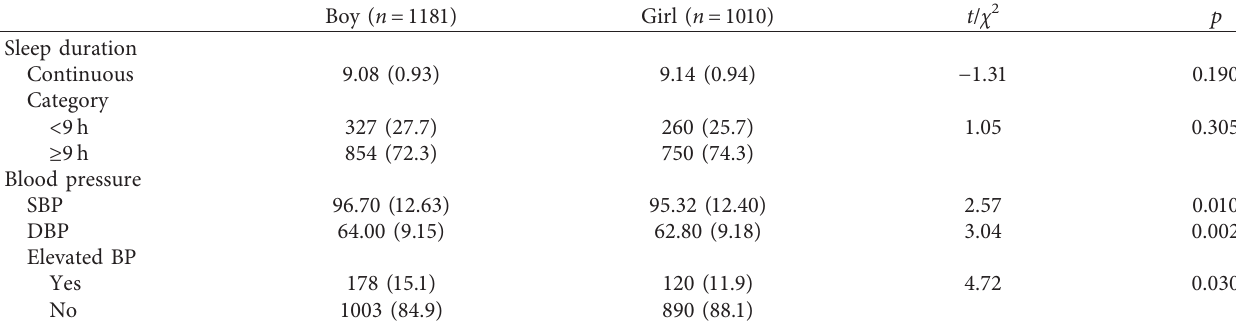
Table 2: The distribution of BP and sleep duration stratified by gender, converging all survey times.